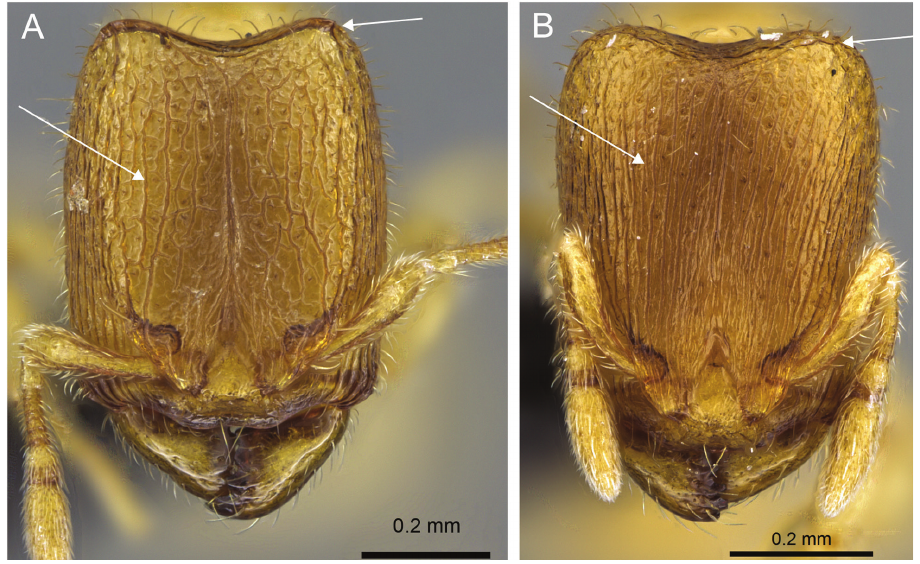
Figure 13. Head in full-face view of A Carebara hainteny (CASENT0039833) B Carebara betsi (CASENT0479444).